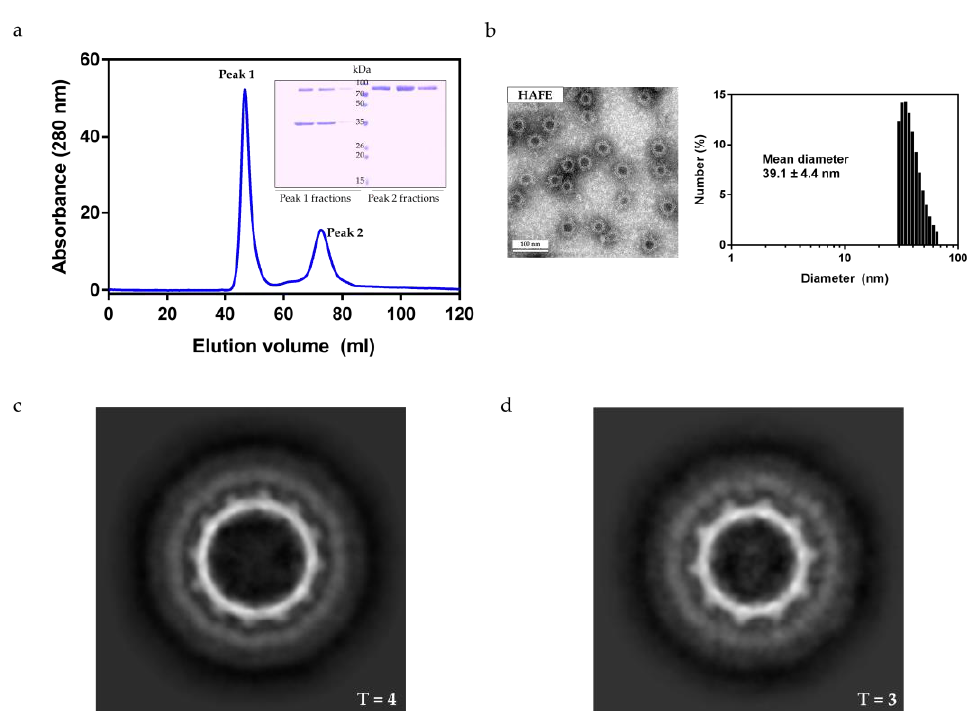
Figure 4. SEC of HAFE and structural analysis of HAFE. ( a ) SEC and SDS-PAGE analysis of HAFE. The purified HAF and EGFR mixture (molar ratio 1:2) were injected into an SEC column. Peak 1 and Peak 2 fractions were visualized through SDS-PAGE analysis. HAFE was eluted in void volume (Peak 1), and the residual EGFR was eluted in Peak 2. ( b ) TEM and DLS analysis of purified HAFE. The measured mean diameters of HAFE were longer than those of HAF, which was attributed to the EGFR being bound to HAF. ( c ) The most populated 2D class-averaged images of HAFE (T = 4 state). ( d ) The most populated 2D class-averaged images of HAFE (T = 3 state).